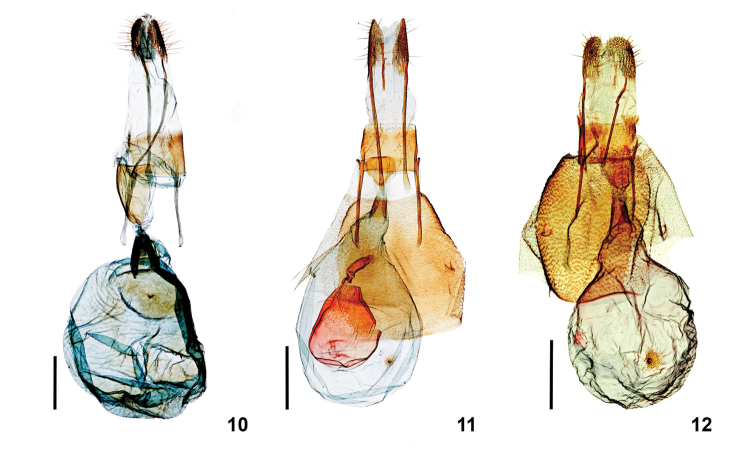
Female genitalia. 10Stamnodes
fergusoni (TAM-2019-001); 11Stamnodes
fervefactaria (USNM55243); 12Stamnodes
deceptiva (USNM59079). Scale bar: 1 mm.